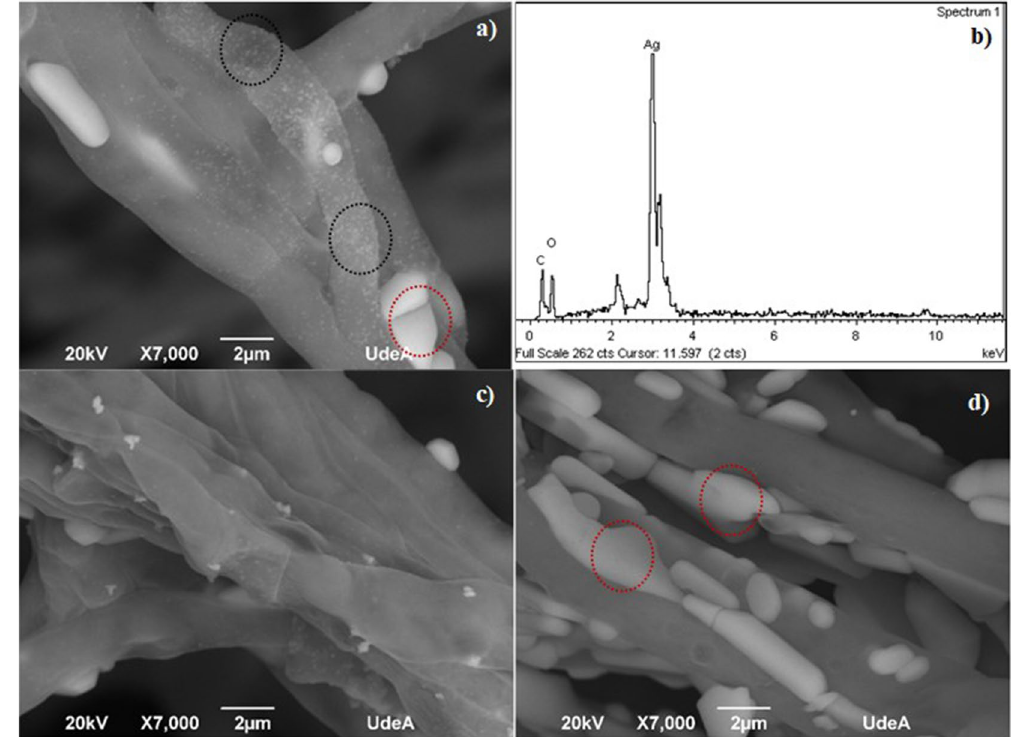
Figure 5. SEM–EDX analysis of the anamorphous Bjerkandera sp. R1 ( a ) 1 mM AgNO 3 solution. Growth time: 7 days, incubation time 144 h. ( b ) EDX spectra 1 mM AgNO 3 solution. Growth time: 7 days, incubation